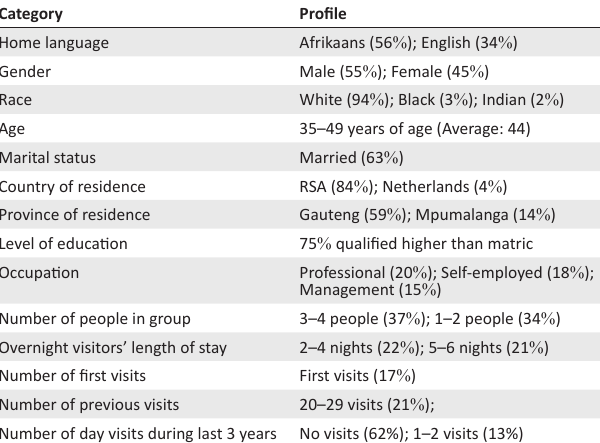
TABLE 2: Visitor profile at the Kruger National Park (2009).